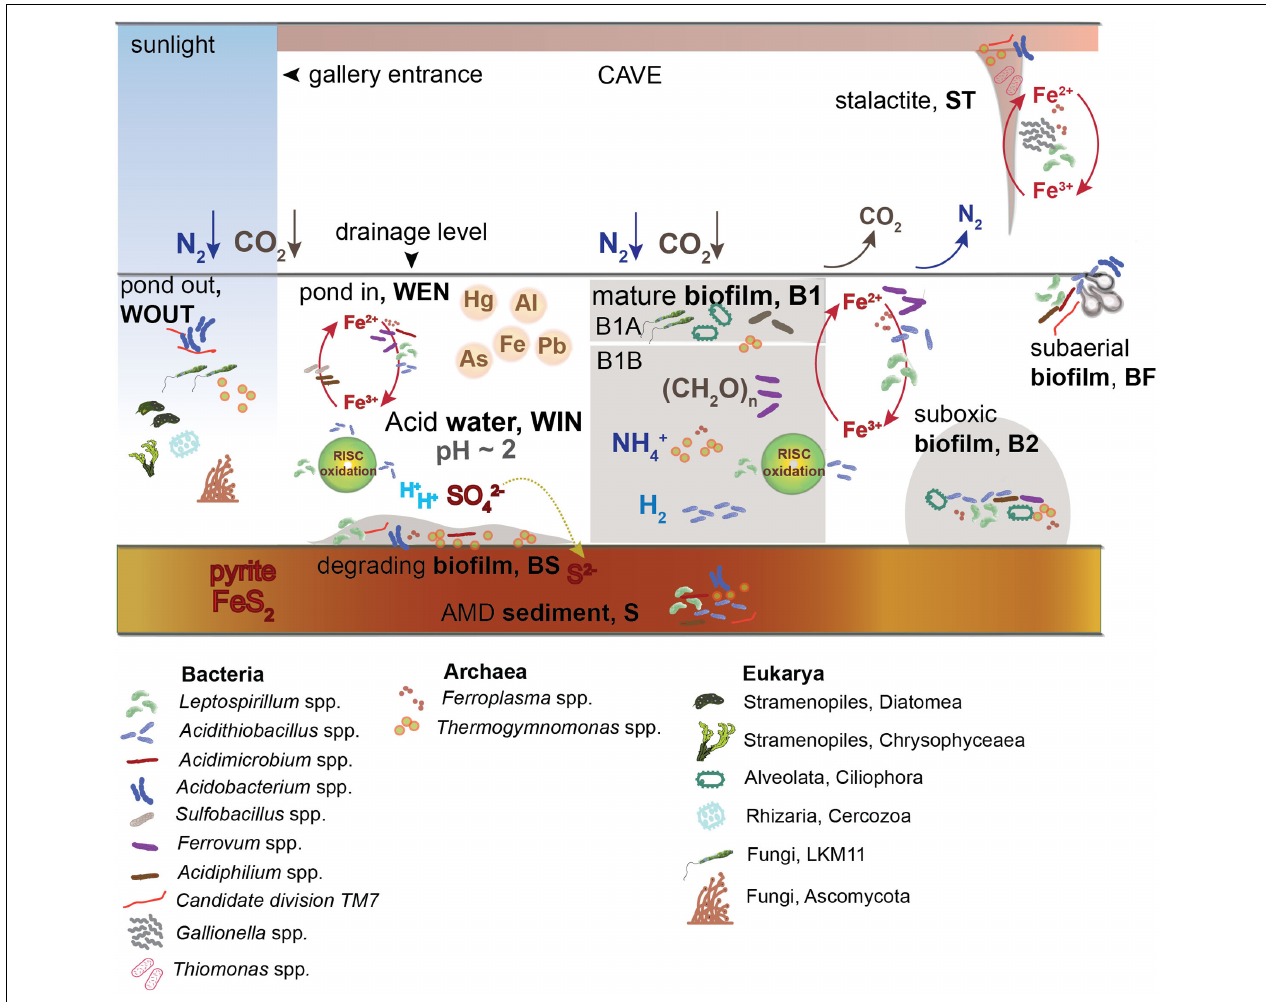
FIGURE 7 | Summarized model integrating diversity and predicted function in Los Rueldos microhabitats (mineral, water, and biofilm). Leptospirillum spp., Acidithiobacillales, and Betaproteobacteria are probable drivers of iron and sulfur oxidation in mineral (S and ST), water (WOUT, WEN, and WIN), and biofilm samples (BS, B1A, B1B, B2, and BF). The distribution of the neutrophilic iron oxidizer Gallionella is restricted to the stalactite ST. Carbon fixers are predictively photosynthetic in water ponds outside the gallery and are mainly represented by Cyanobacteria. Leptospirillum spp. are suggested to perform inorganic carbon and nitrogen fixation in all microhabitats inside of the cave. Decomposition of organic matter in the drainage accumulating outside of the gallery (WEN) would support the life of heterotrophic community members (Fungi, Protozoa, Proteobacteria, and Archaea) in this compartment. The extracellular polymeric matrix of the biofilms would constitute the main carbon source inside of the gallery, supporting the heterotrophic lifestyle of most abundant microbial groups present in the cave (Ciliates, Proteobacteria, and Archaea). The stagnant nature of the AMD would favor the existance of marked microhabitats along the drainage. Biofilm ciliates could have an impact on the population structure of bacterial members of the community, and the presence of different genera in distinct biofilm strata likely relates to differential bacterial/archaeal community composition, suggesting adaptation to distinctive environmental variables (oxic/hypoxic, water/mineral